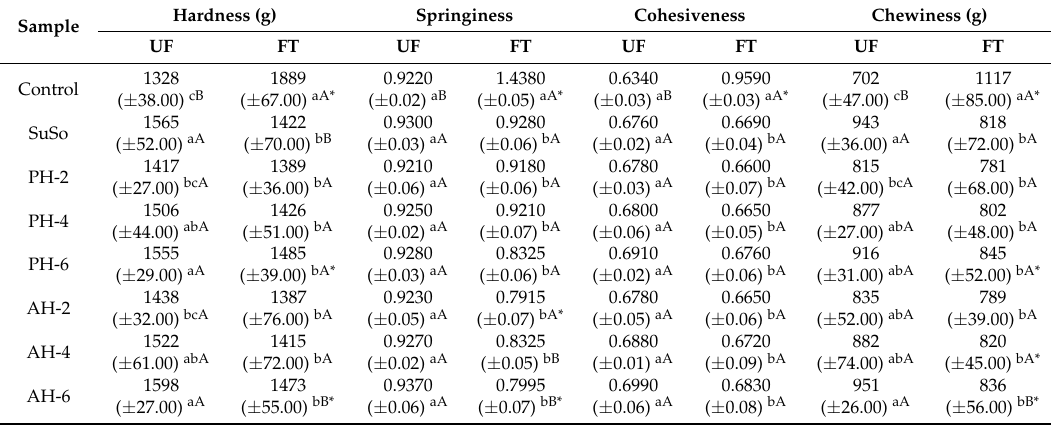
Table 4. Texture profile analysis of different heat-set surimi gels before (unfrozen, UF) and after six freeze-thaw cycles